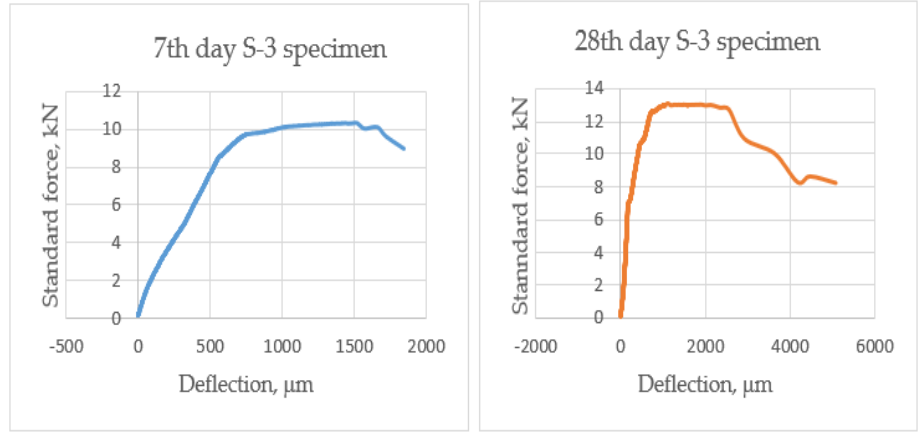
Figure 10. Crack behavior of sample S-3 after 7 and 28 days of hardening.